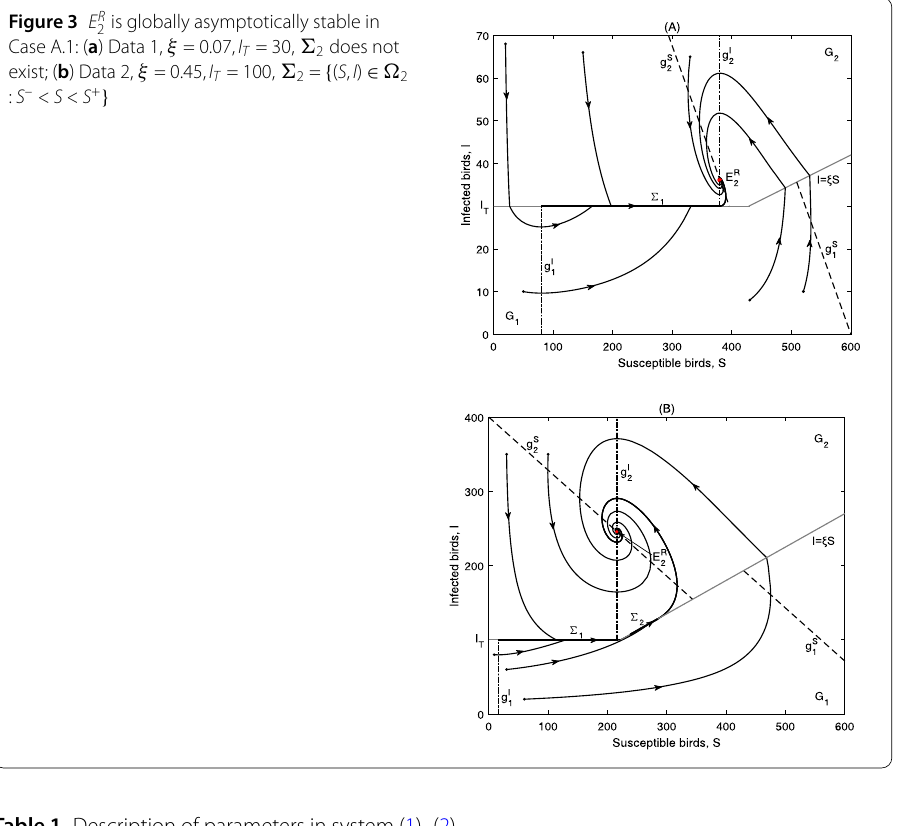
Table 1 Description of parameters in system